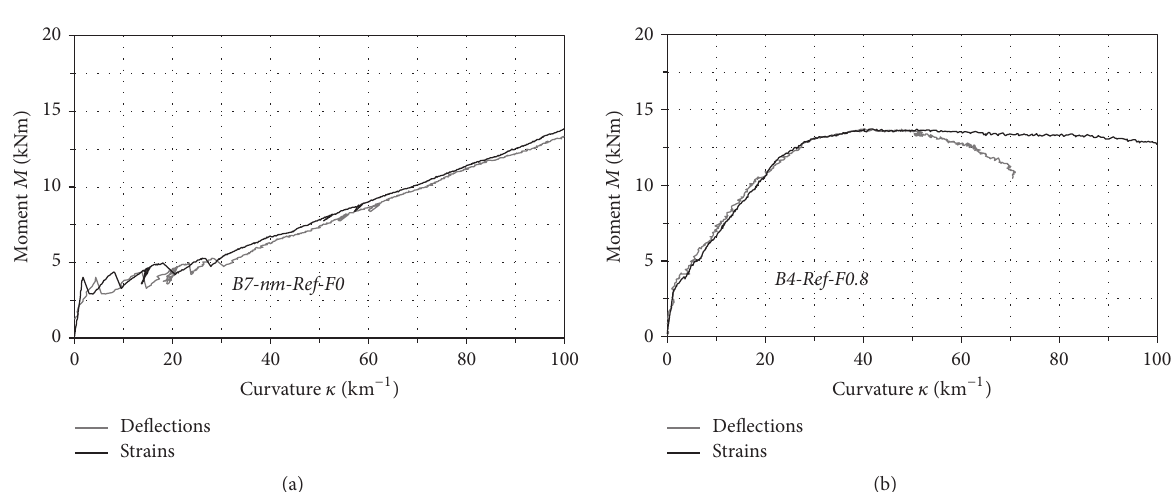
Figure 8: Moment-curvature diagrams of selected beams obtained using the monitoring results of surface strains and